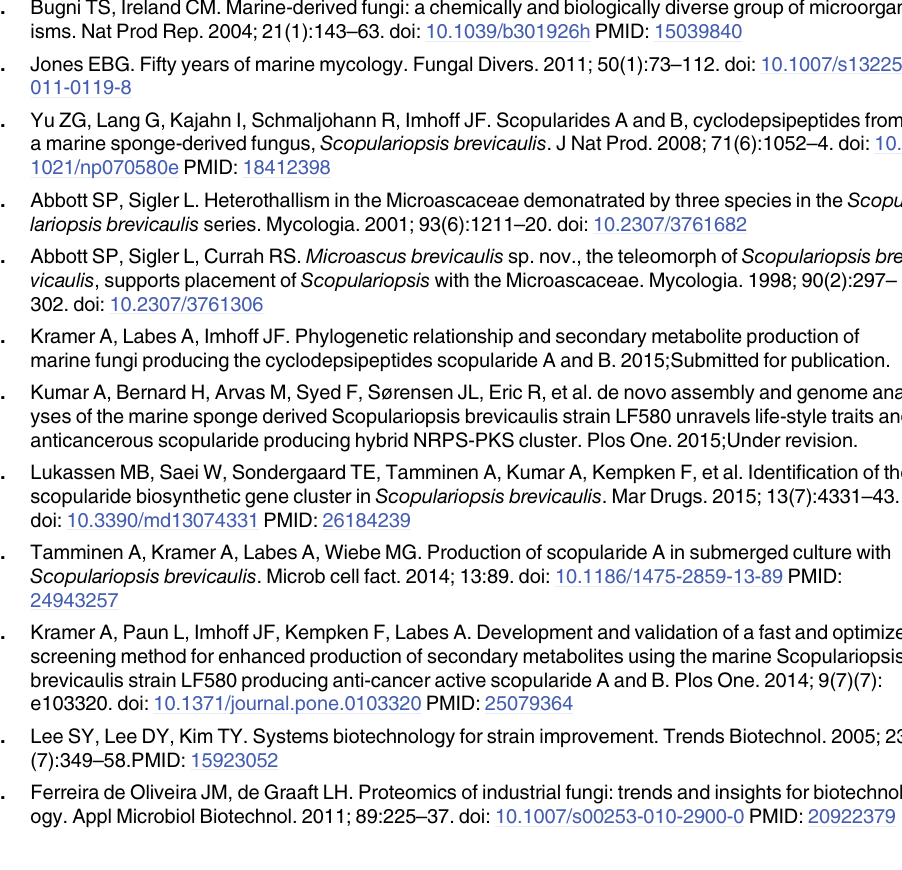
S1 File. Table of analysed proteins from M . brevicaulis LF580 and its mutant LF580-M26. Qualification and quantification of proteins of LF580 were determined in a MS-MS based pro- teome analysis (Table A). An iTRAQ labelling approach was used to compare the proteomes of LF580 and LF580-M26 (Table B). Proteins were associated to functionality using a Gene ontol- ogy analysis (Table C) and a KEGG pathway analysis (Table